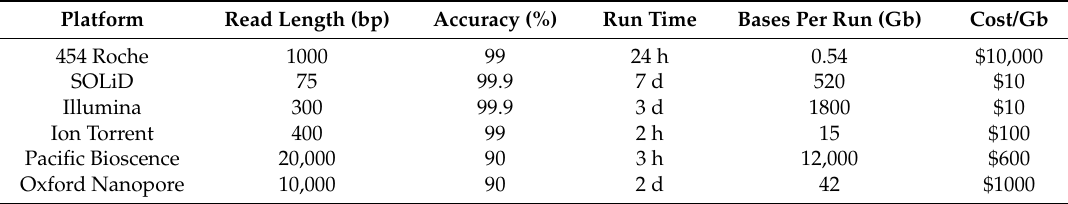
Table 2. Comparison of the different sequencing platforms. The data shown refer to the most favorable conditions for each platform.